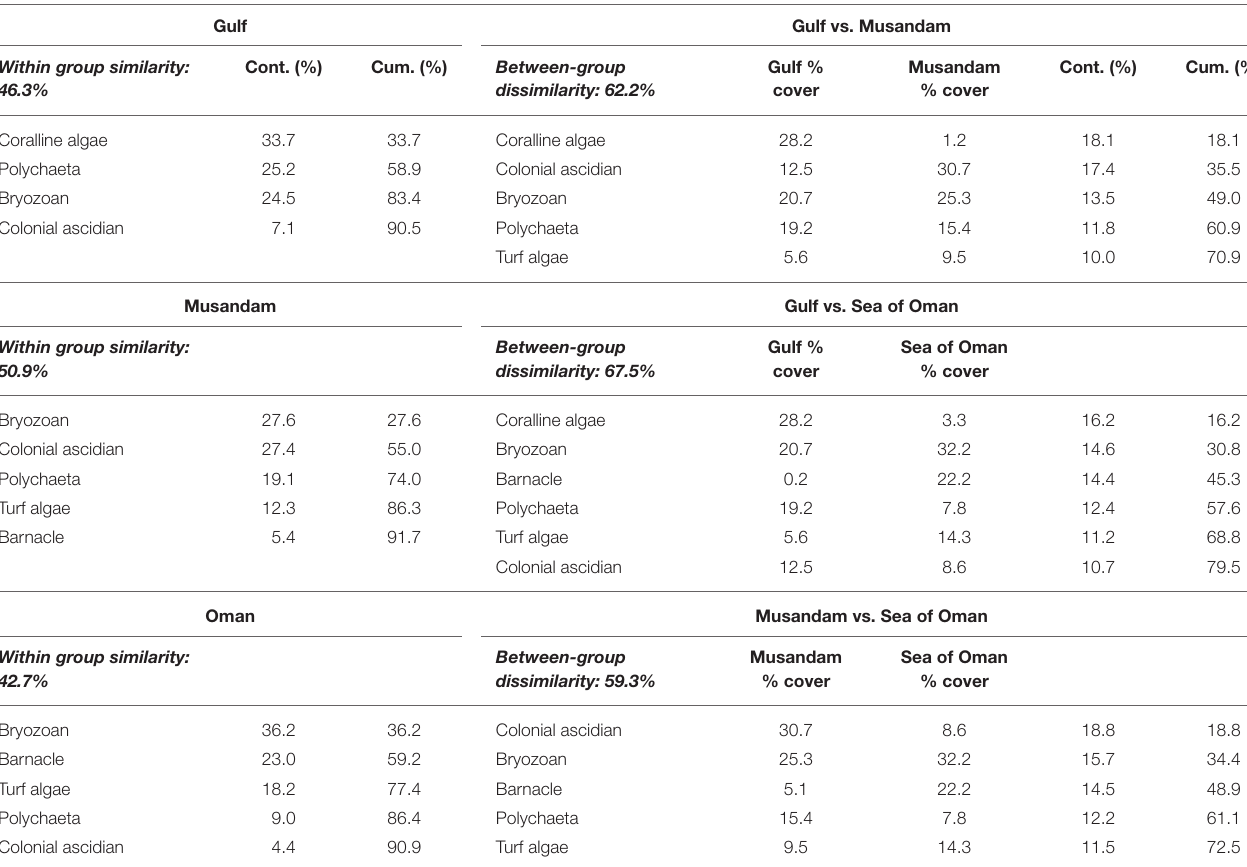
TABLE 1 | Benthic groups responsible for > 90% of within-regions similarities and > 70% of among-regions dissimilarities based on SIMPER analysis. Gulf Gulf vs. Musandam